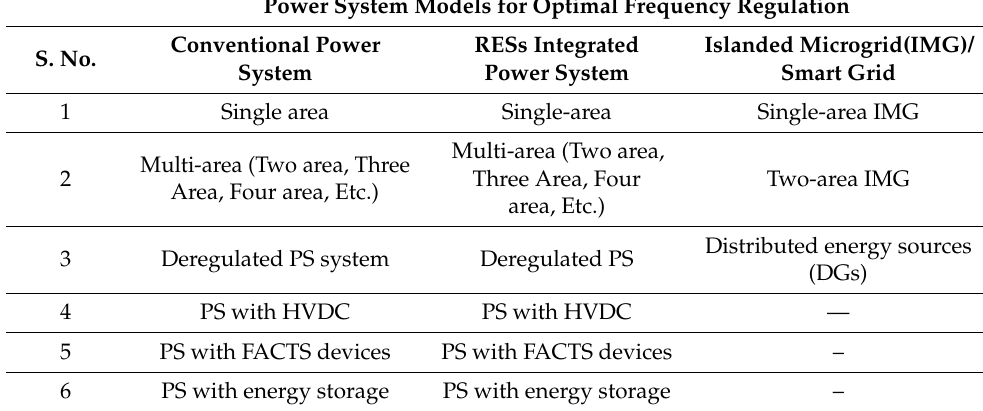
Table 1. Representation of power systems: conventional, hybrid, and future power systems.